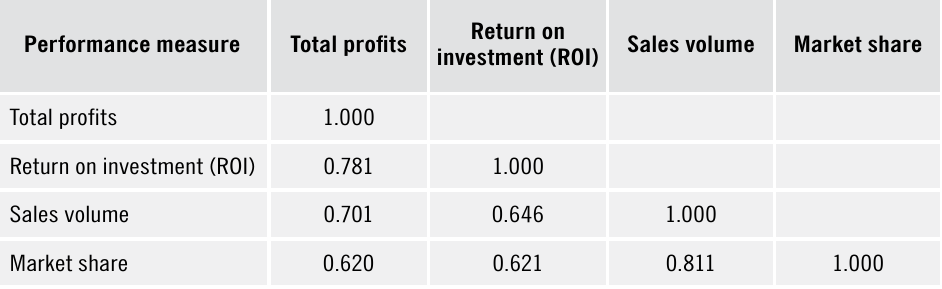
Table 4. An analysis of the correlation between performance measures: consolidated performance indicator